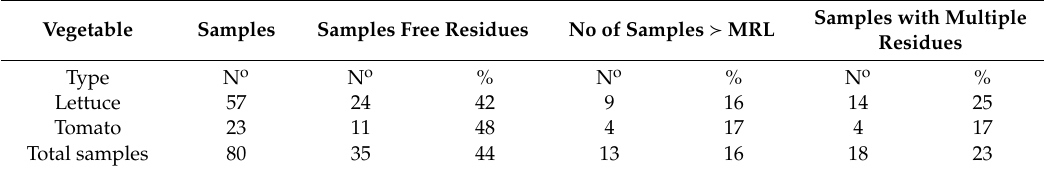
Table 3. The pesticide residues detected in